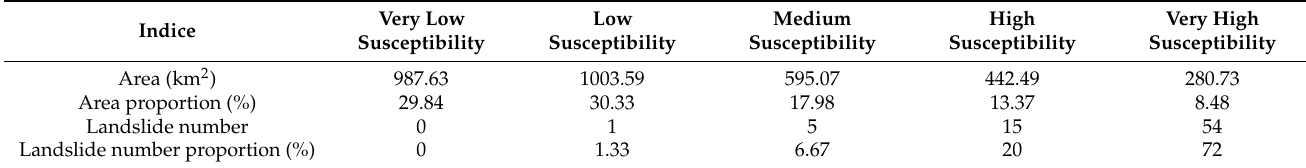
Table 3. Landslide susceptibility statistics.